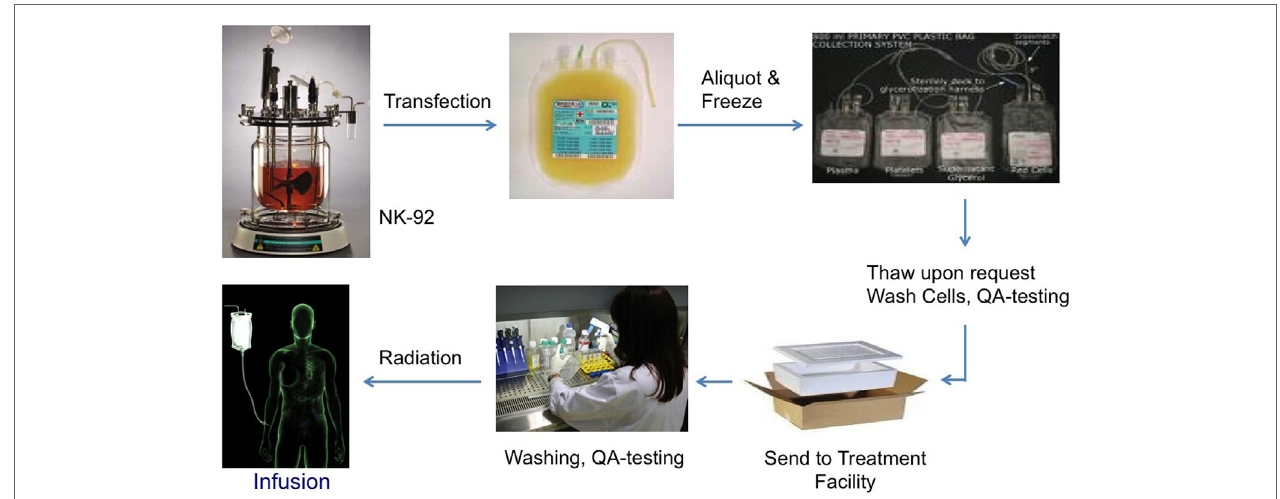
FiGURe 3 | Biologistics of NK-92 as an “off-the-shelf” cellular therapeutic